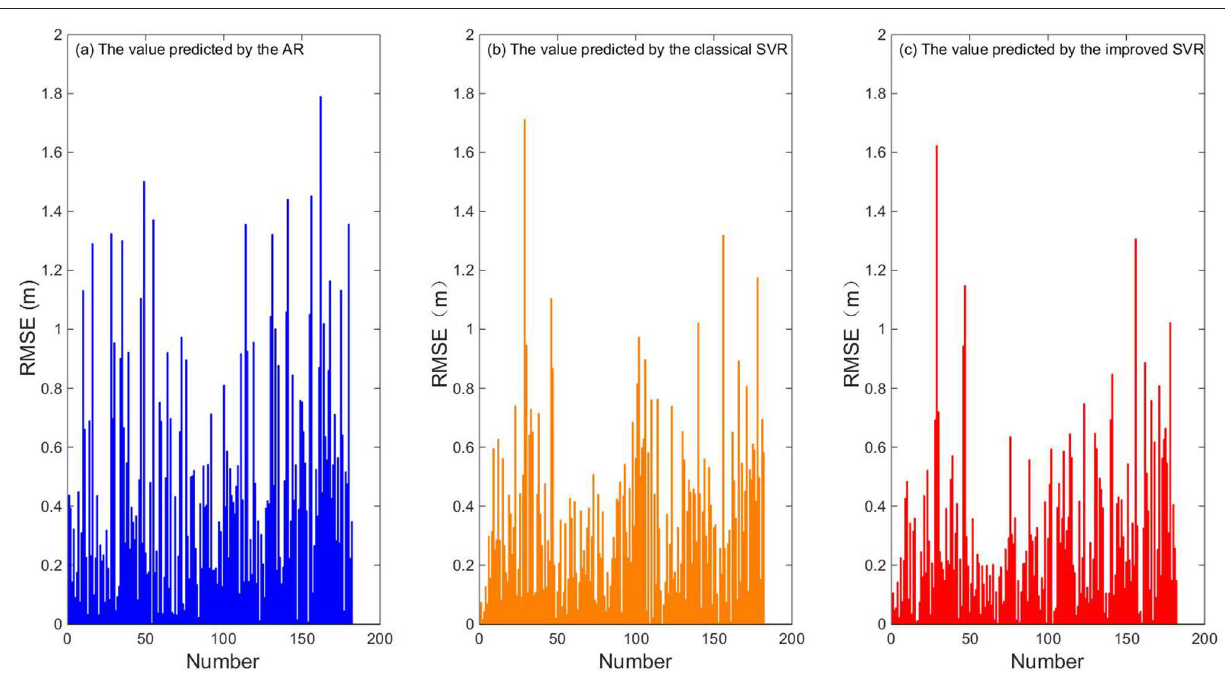
FIGURE 9 | RMSE of evaporation duct